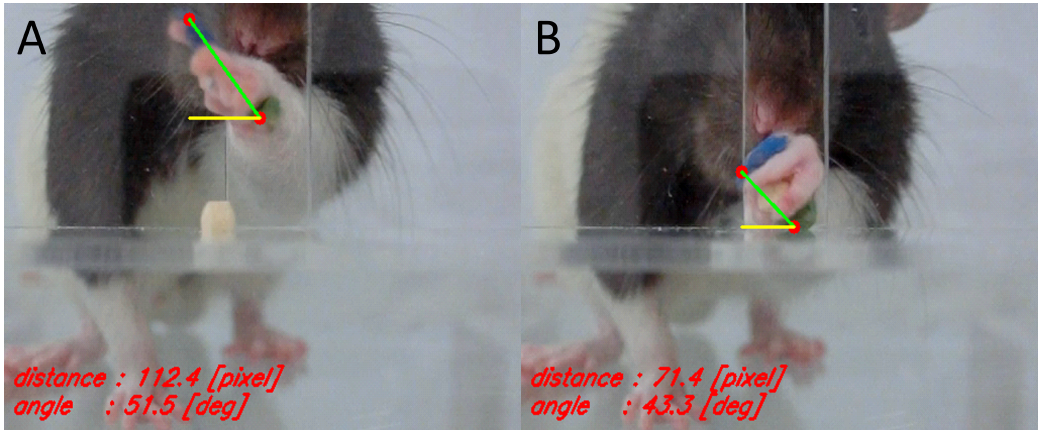
Fig. 2. Frontal-view image analysis. The tip of the first and fifth fingers (red dots) is determined by fitting an ellipse onto each finger’s extracted color (blue) images. Images of pronation (A) and supination (B) measure the distance between the first and fifth fingertips as indicated by the green lines. The angle betweenthefingertiplineandthefrontalshelfhorizontallineisalsoanalyzed(anglesdepictedbetweenyellowandgreenlines). Thesevaluesareautomatically displayed at the bottom corner of each image.